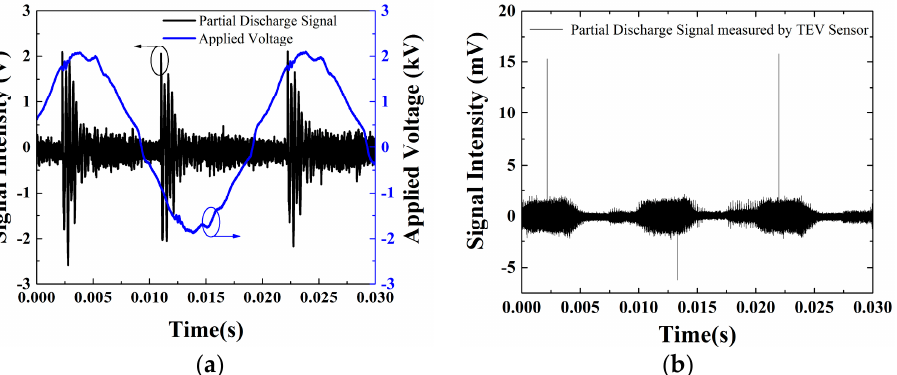
Figure 7. ( a ) The applied voltage and the partial discharge signal detected by the interferometer system. ( b ) The partial discharge signal detected by the transient earth voltage (TEV) sensor.